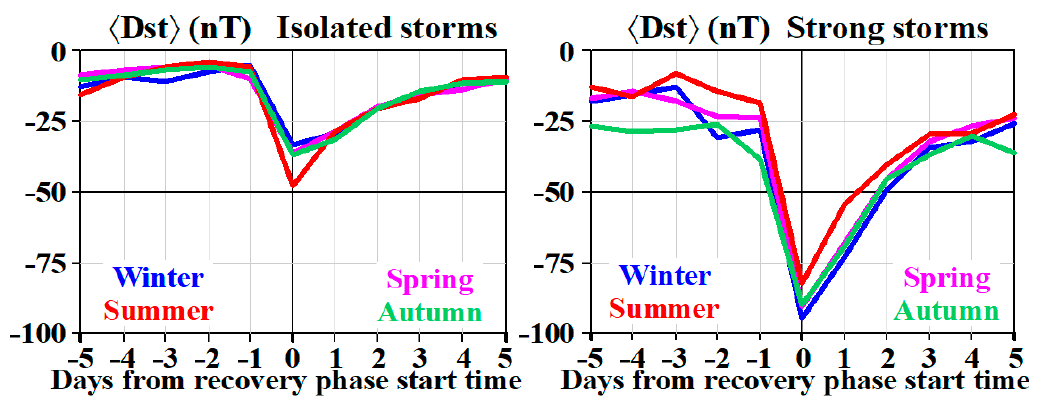
Figure 1. Averaged Dst index as function of day from beginning of geomagnetic storm recovery phase for isolated ( left panel ) and strong ( right panel )